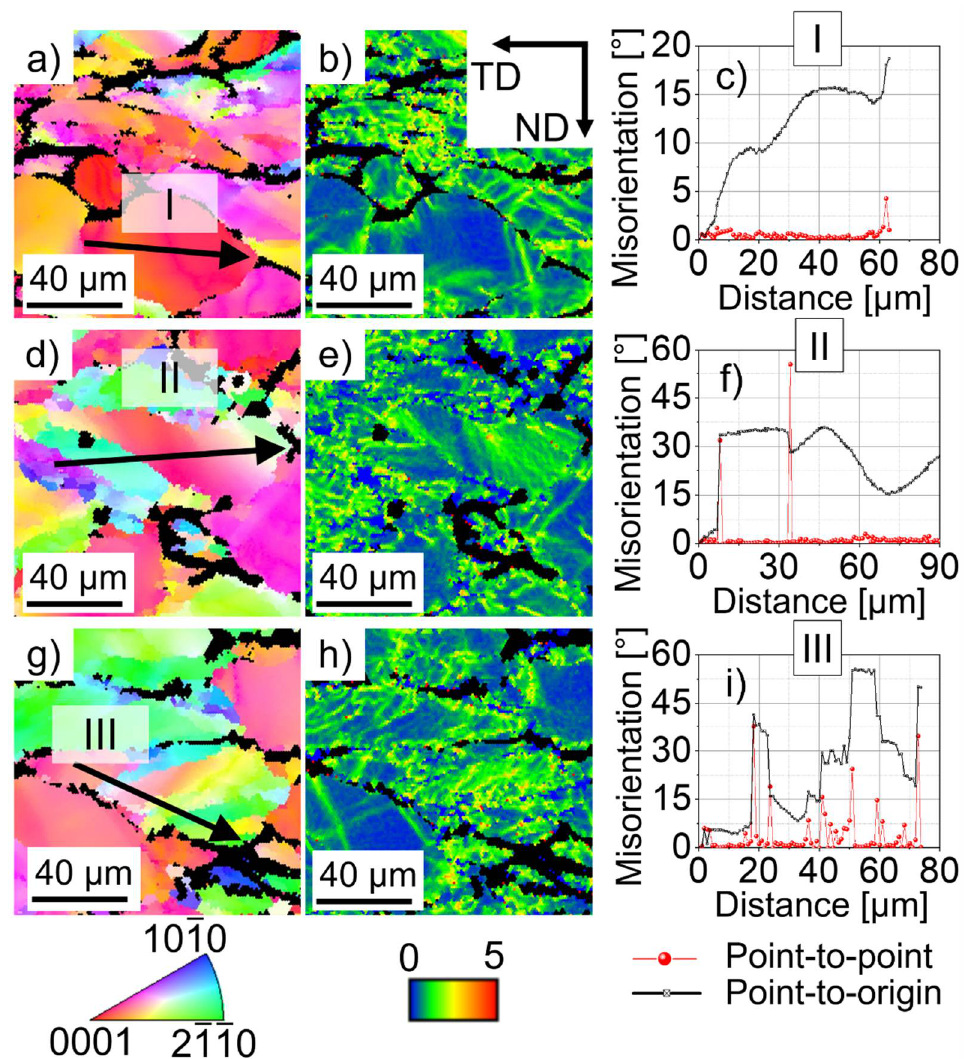
Figure 14. Details of the magnified areas A1 (shown in Figure 4), A2, and A3 (shown in Figure 5) for the ( a – c ) ZK40-CaO deformed at 250 ◦ C and 0.001 s − 1 ; ( d – f ) ZK40-Gd deformed at 300 ◦ C and 0.0001 s − 1 ; ( a , d , g ) inverse pole figure maps; ( b , e , h ) kernel average misorientation profile maps; ( c , f , i ) misorientation profiles I, II and III, respectively. Only α -Mg is indexed. Non-indexed regions are highly deformed regions or intermetallic compounds. ND and TD indicate the compression and transversal directions, respectively.